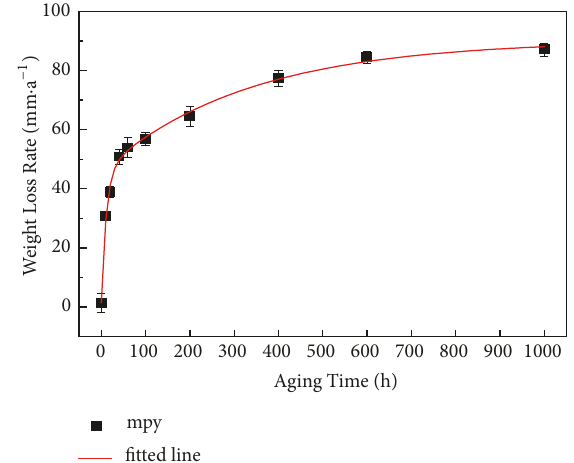
Figure 5: Mass loss rate of Alloy 625 as a function of aging time.